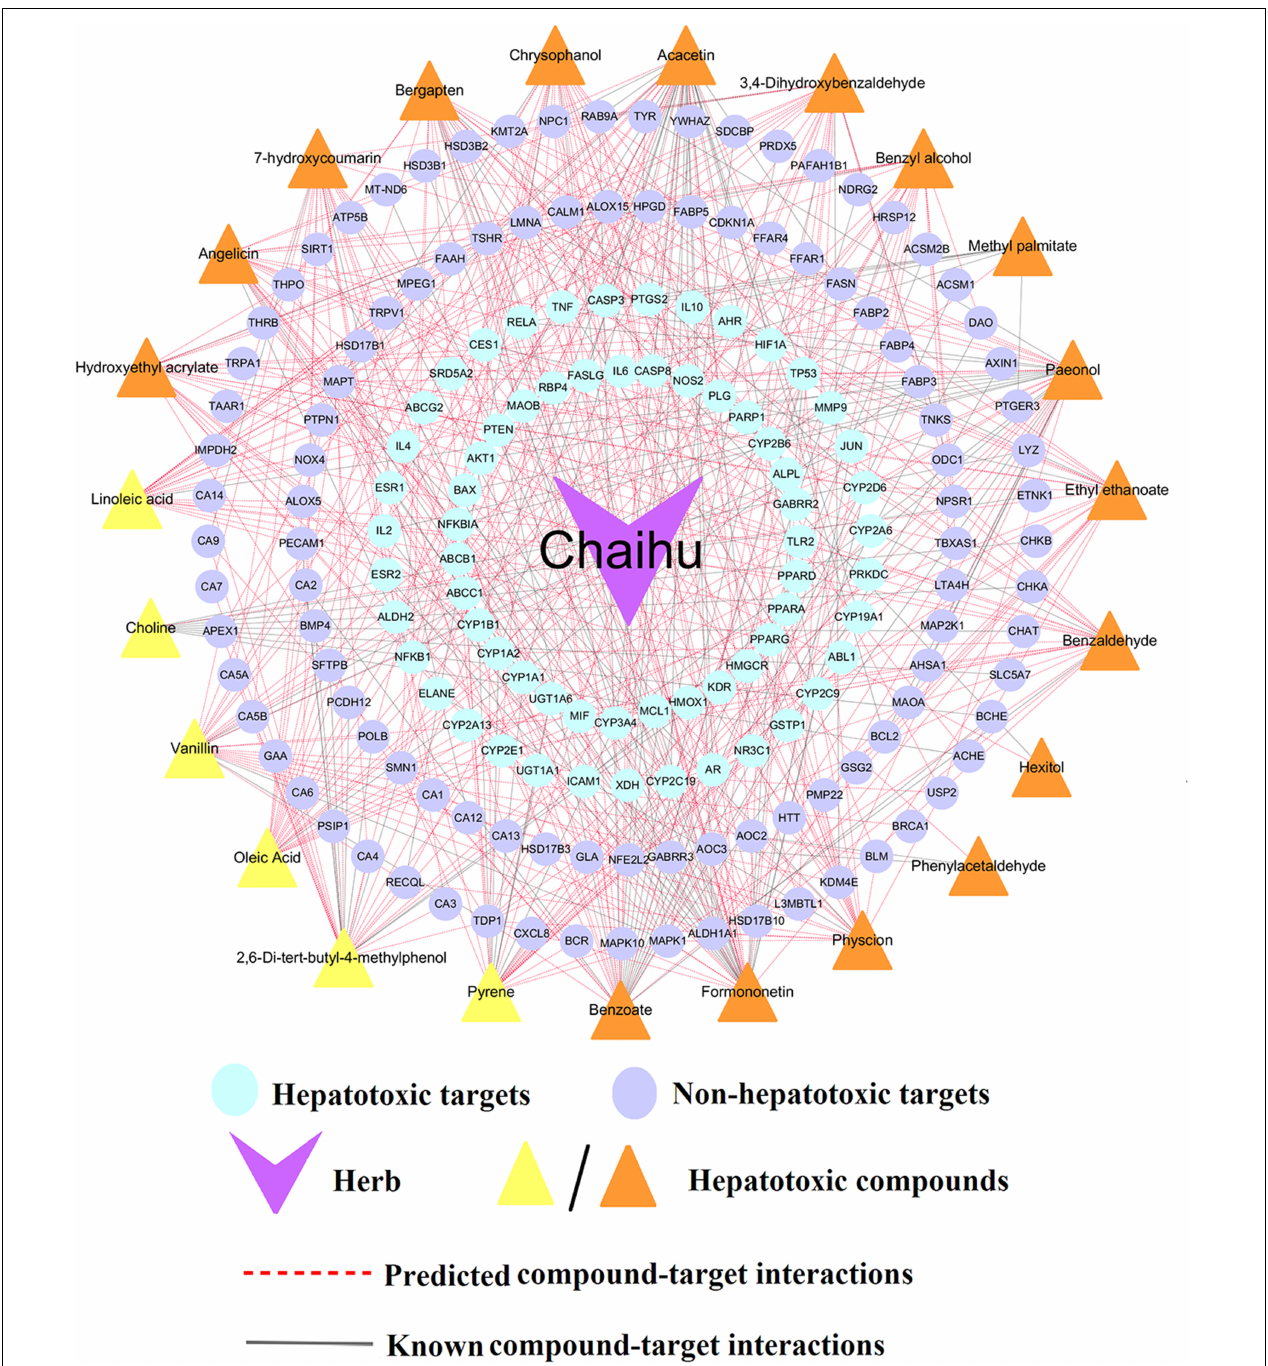
FIGURE 6 | A compound-target (C-T) network of Bupleurum L. ( Chaihu ) contains 133 known and 380 predicted C-T interactions connecting 23 compounds and 172 targets (including 66 hepatotoxic targets and 106 non-hepatotoxic targets). The yellow triangles represent the predicted hepatotoxic compounds validated by literatures, while the orange triangles stand for the predicted hepatotoxic compounds without literature